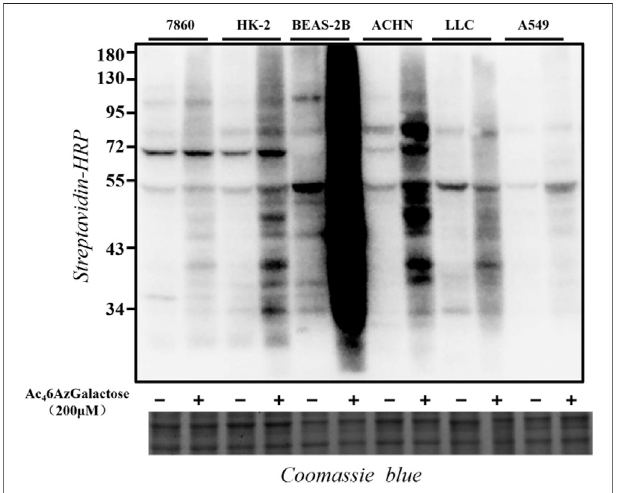
FIGURE 4 | Proteins in different cell lines are labeled upon Ac treatment.